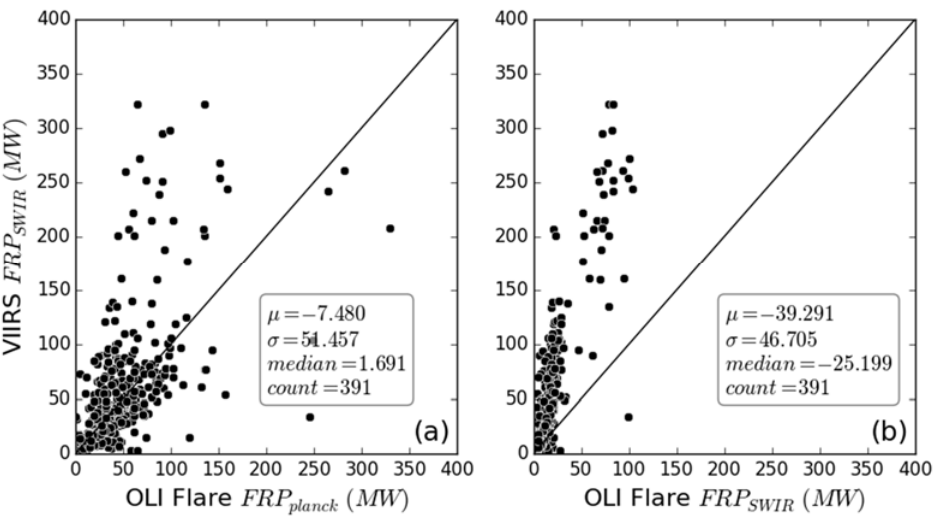
Figure A3. Intercomparison of VIIRS M-Band derived gas flare FRP calculated using the SWIR-Radiance method with that derived from OLI using ( a ) the Planck fit approach, and ( b ) the SWIR-Radiance method. Insets show the statistics for all data points, with 31 flare hotspots used measured across 21 collocated OLI and VIIRS images—providing a total of total of 391 comparisons.